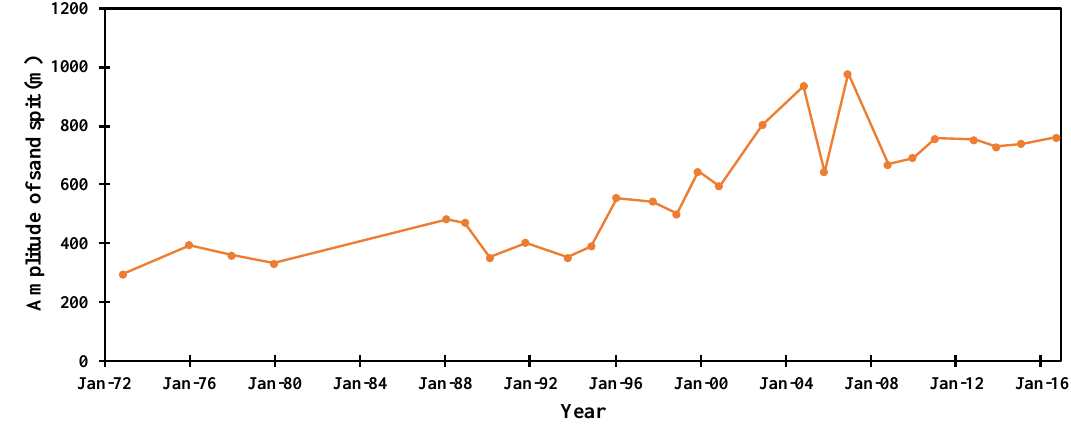
Figure 17. Variation in the amplitude of the sand spit from 1972 to 2015.